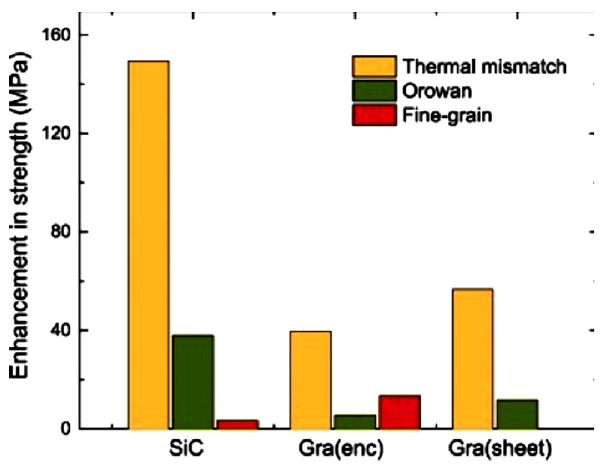
Figure 8: Strengthening mechanism in enhancing the tensile strength with the addition of SiC, encapsulating graphene, and sheet graphene. Reproduced from ref. [ 66 ] .